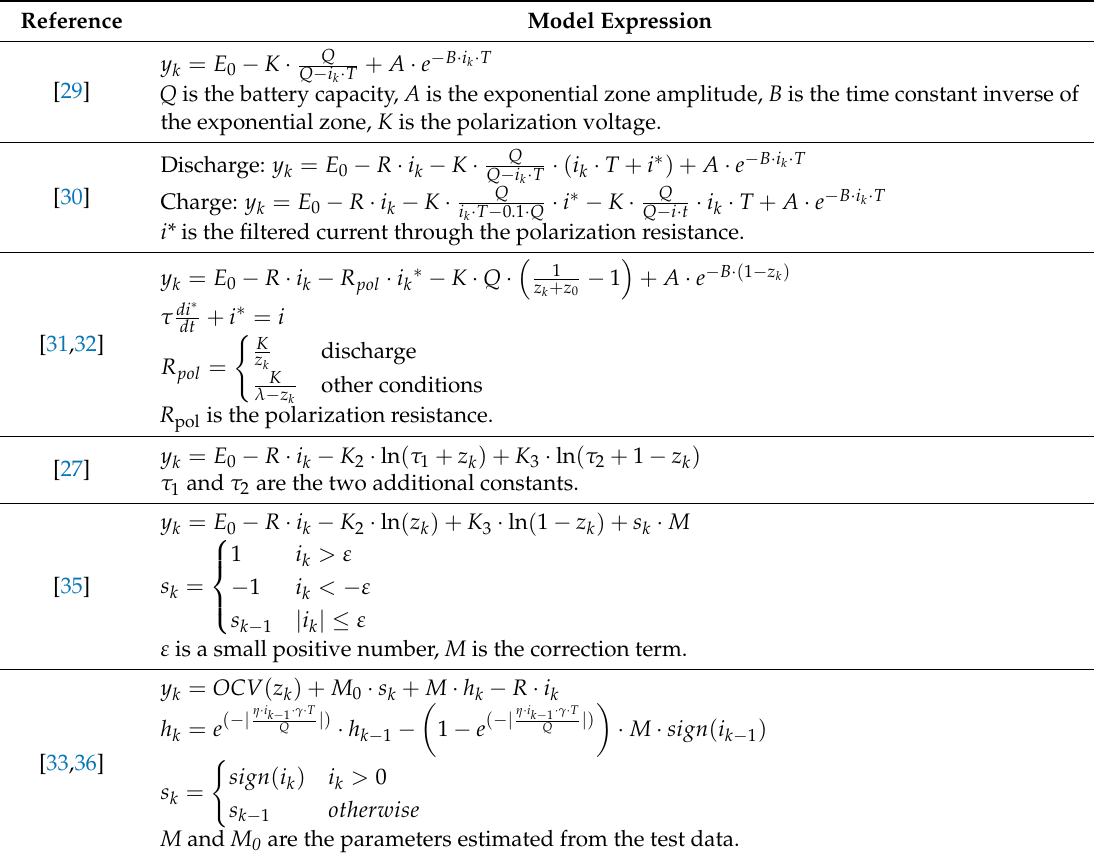
Table 2. Modified empirical